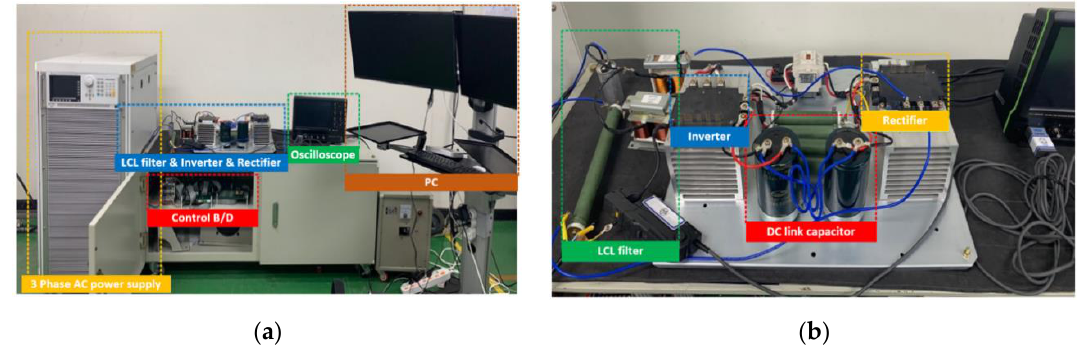
Figure 9. ( a ) Experimental set-up, ( b ) a GCI and a passive low pass filter.